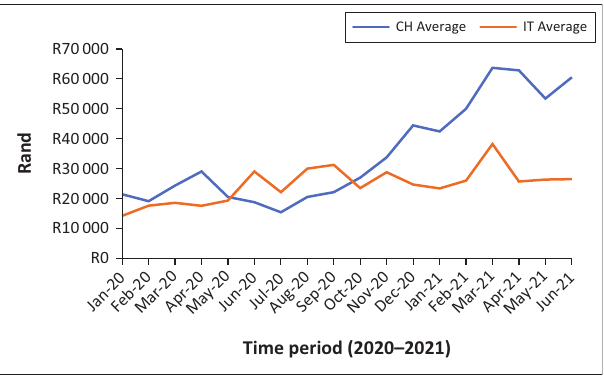
FIGURE 3: Average 40-ft container freight rates for imports from China and Italy to Durban: